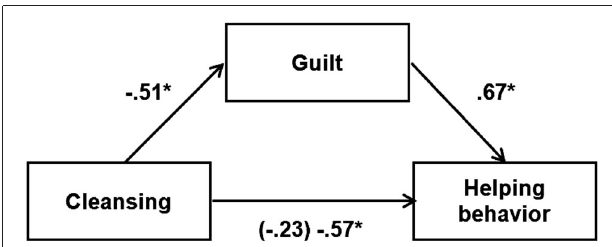
FIGURE 1 | Mediating effect of guilt on the relationship between cleansing and prosocial behavior . Note . The standardized regression coefficient in parentheses was obtained from a model that included both cleansing and guilt as predictors of prosocial behavior. * p <